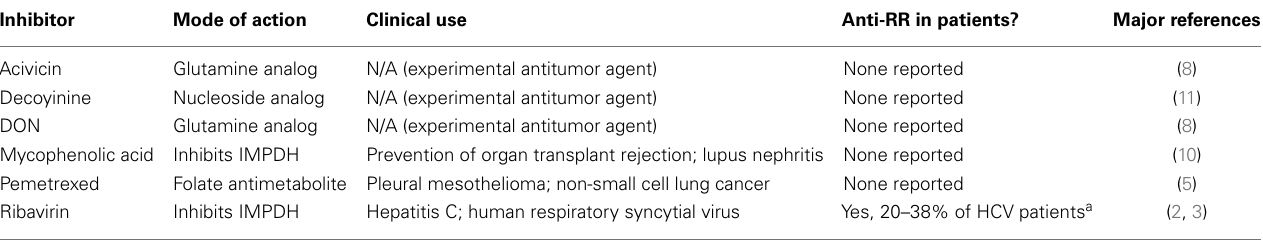
Table 1 |Associations between RR-inducing inhibitors and anti-RR production